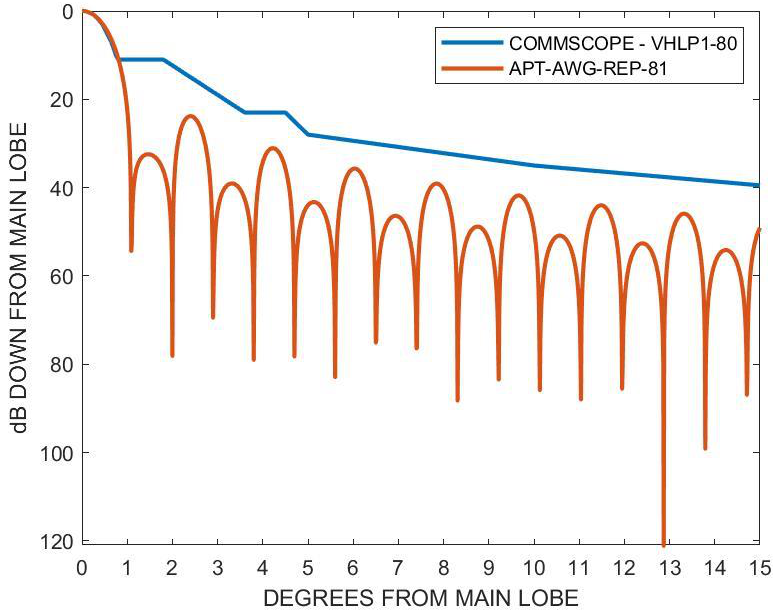
Figure 5. Radiation pattern envelope as a function of the misalignment angle using Equation (12) compared to the manufacturer’s data.